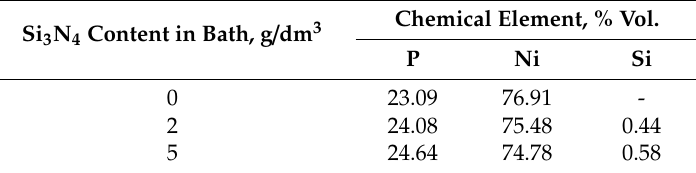
Table 4. Content of elements of Ni-P / Si 3 N 4 layers.